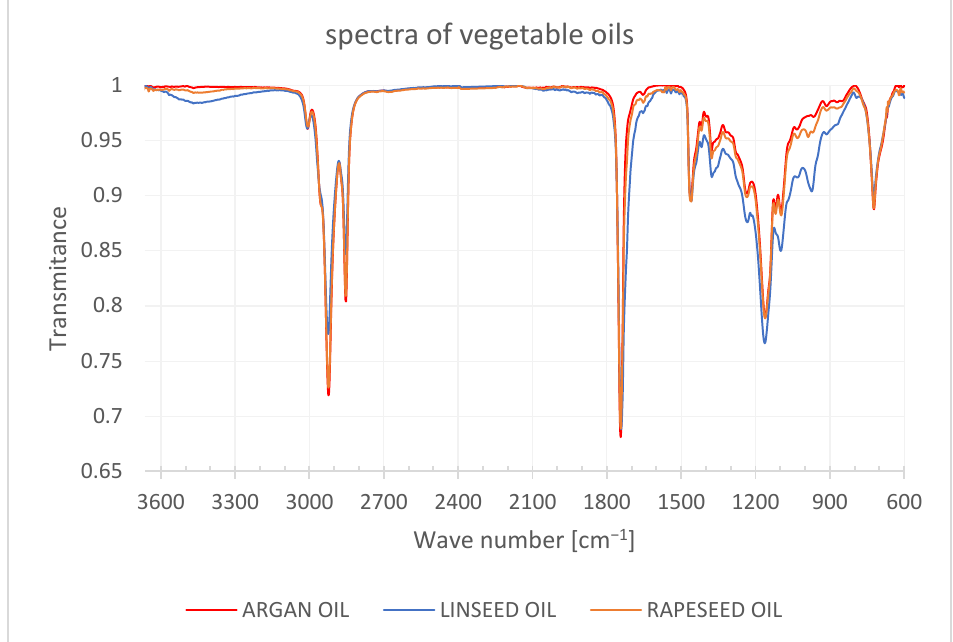
Figure A2. Spectra of the vegetable oils. Table A1. Wave numbers of monomers.